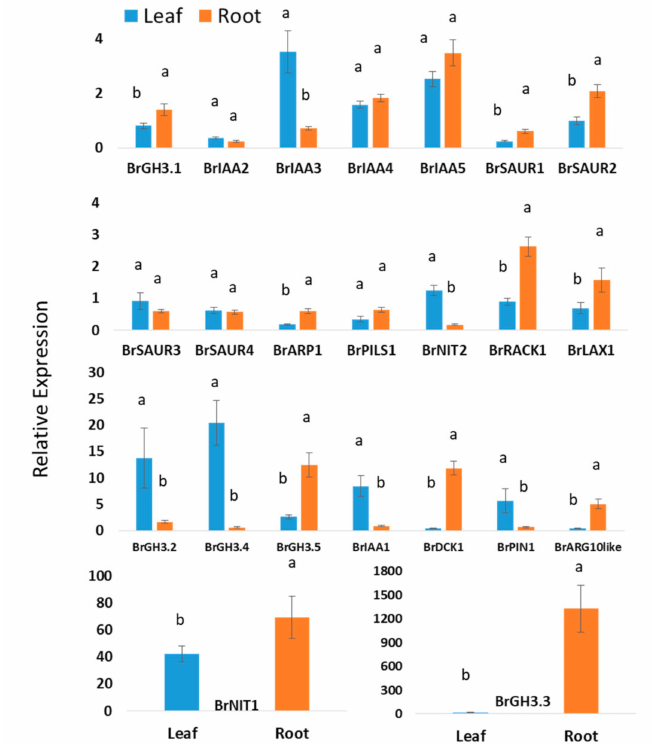
Figure 2. Relative expression level di ff erences in auxin-biosynthesis related genes between leaf and root samples: Each data point represents an average value of Seosan-inoculated plus mock-treated samples of all five time-points, i.e., an average of 30 samples. The letters “a” and “b” denote statistically significant di ff erences between leaves and roots at the 5% level of significance. Vertical bars represent standard errors. Expression of genes in leaf tissues of control (nontreated) plants on day 0 were set to